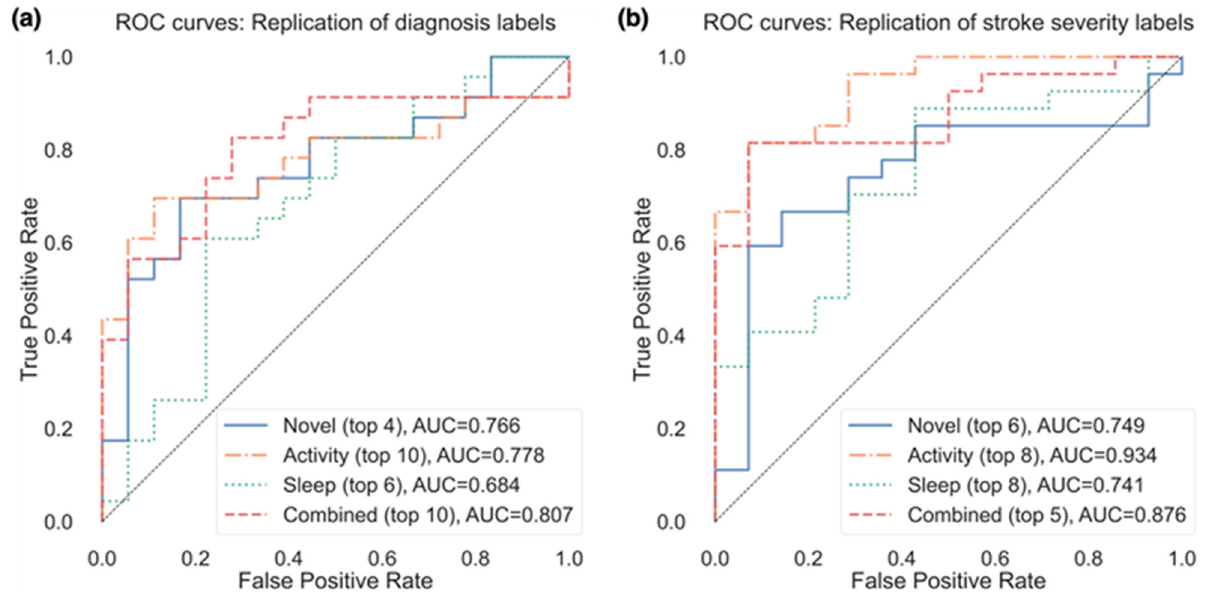
second choice etc.).